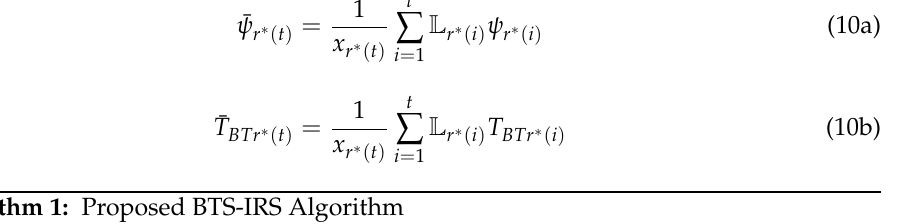
Algorithm 1: Proposed BTS-IRS